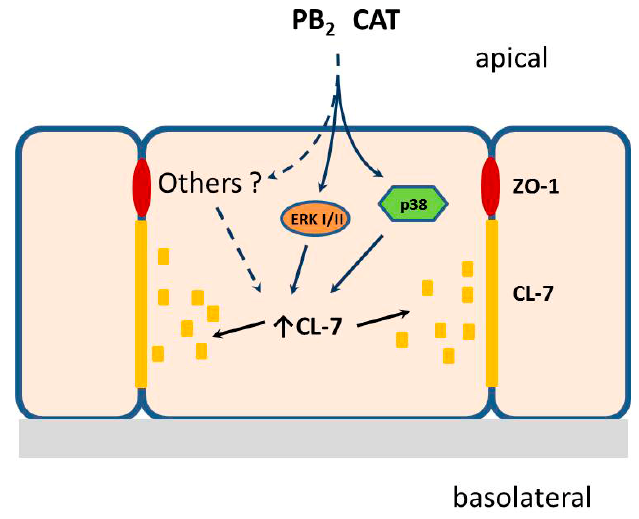
Figure 6. A tentative model to summarize polyphenol-dependent induction of CL-7 in Figure 6. Caco-2/HT29-MTX co-culture system.